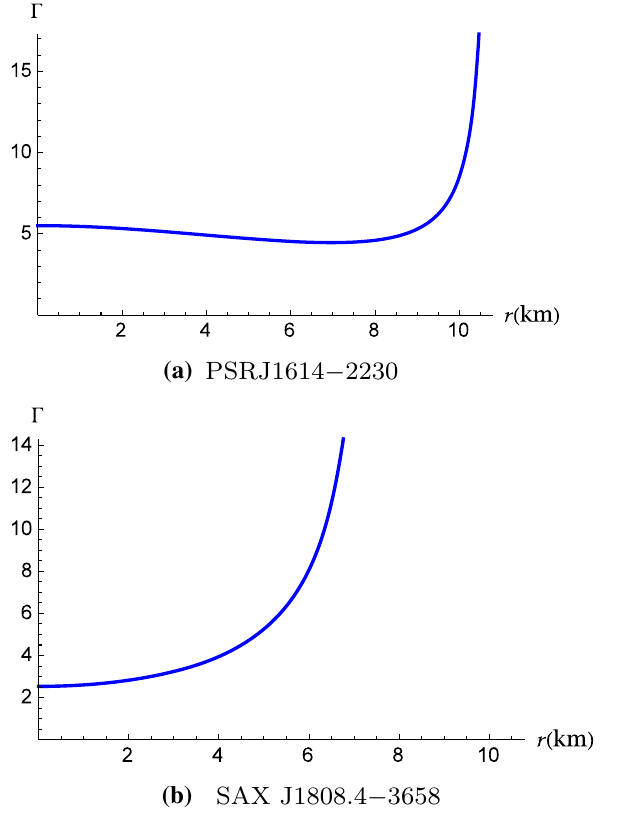
Fig. 10 Variation of adiabatic index verses the radius